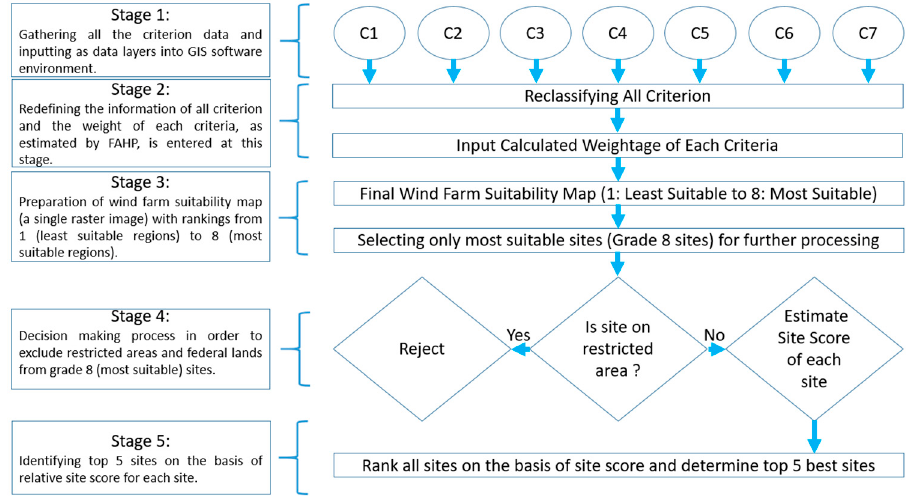
Figure 5. Layout process for development of wind farm suitability maps.